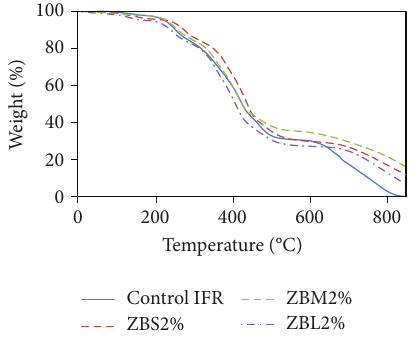
Figure 16: TG curves of IFR/ZB coatings (under nitrogen).